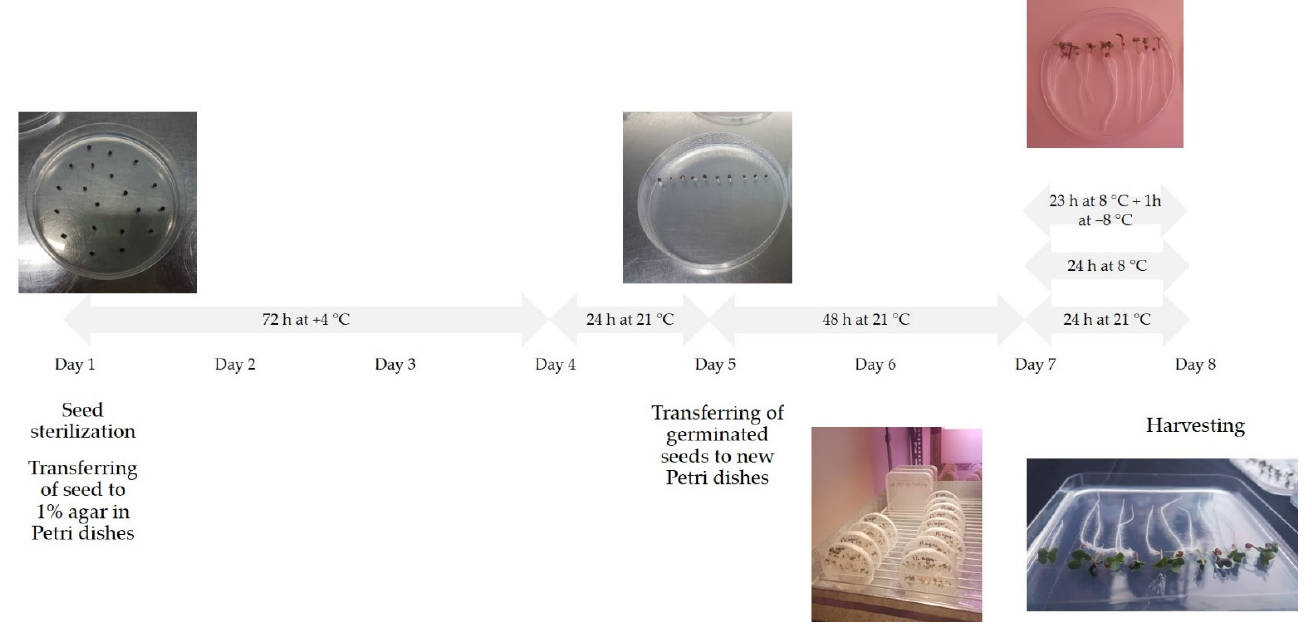
Figure 1. Shematic diagram of the experimental